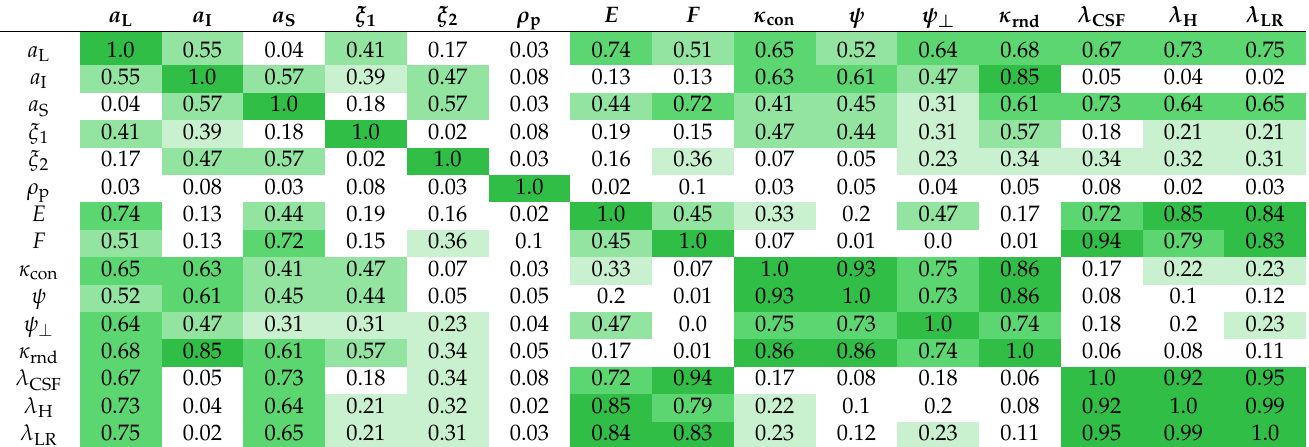
Table 2. Absolute Values of the correlation coefficients according to Pearson [61] for the considered shape